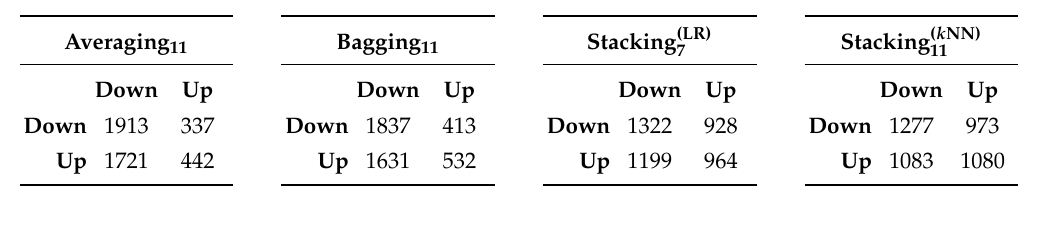
Table 11. Confusion matrices of Averaging 11 , Bagging 11 , Stacking (LR) CNN-BiLSTM as base model for ETH dataset.